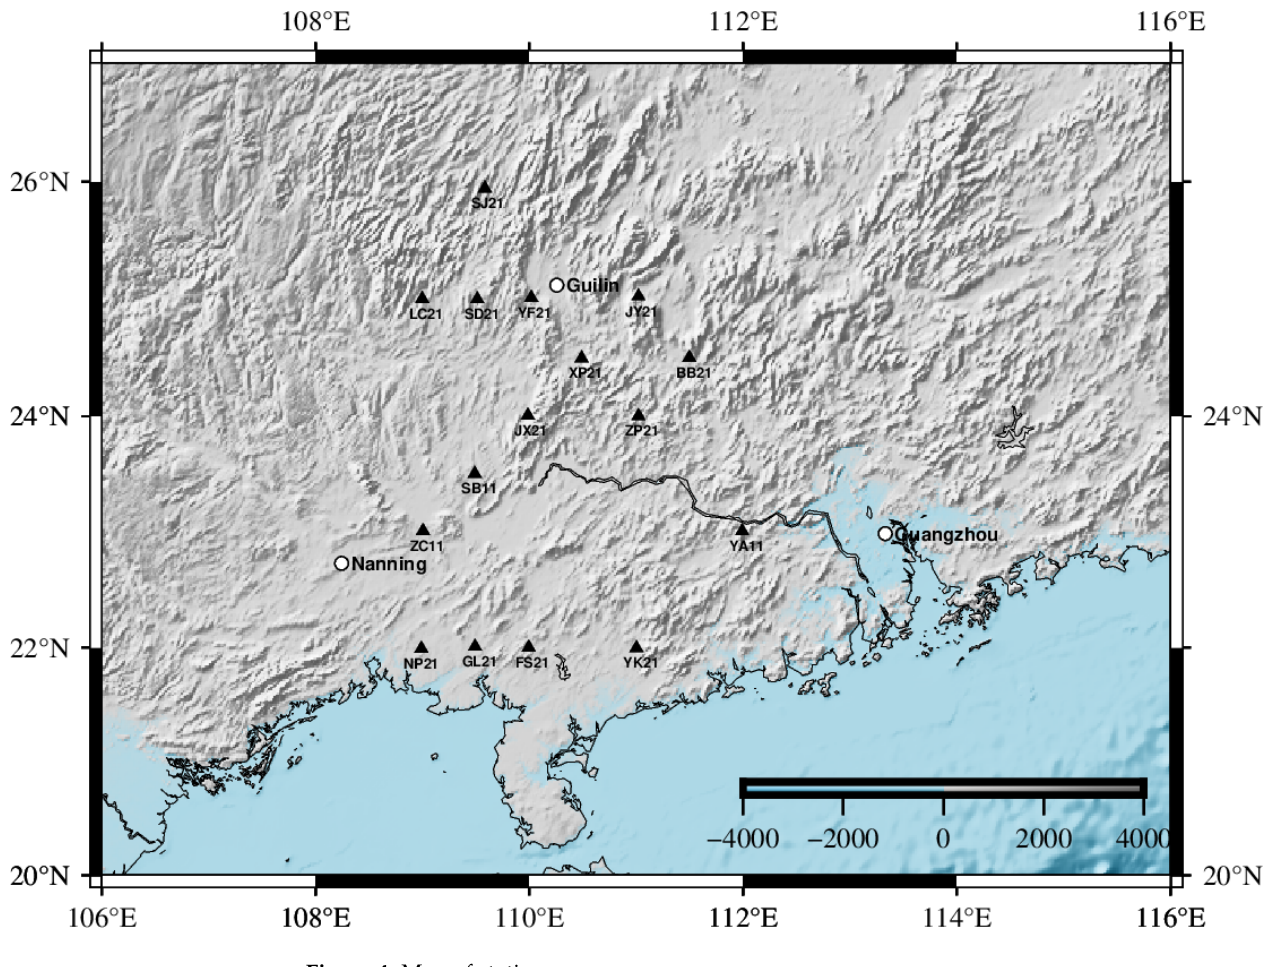
Table 2. Parameters of seismic events (parameters from USGS).